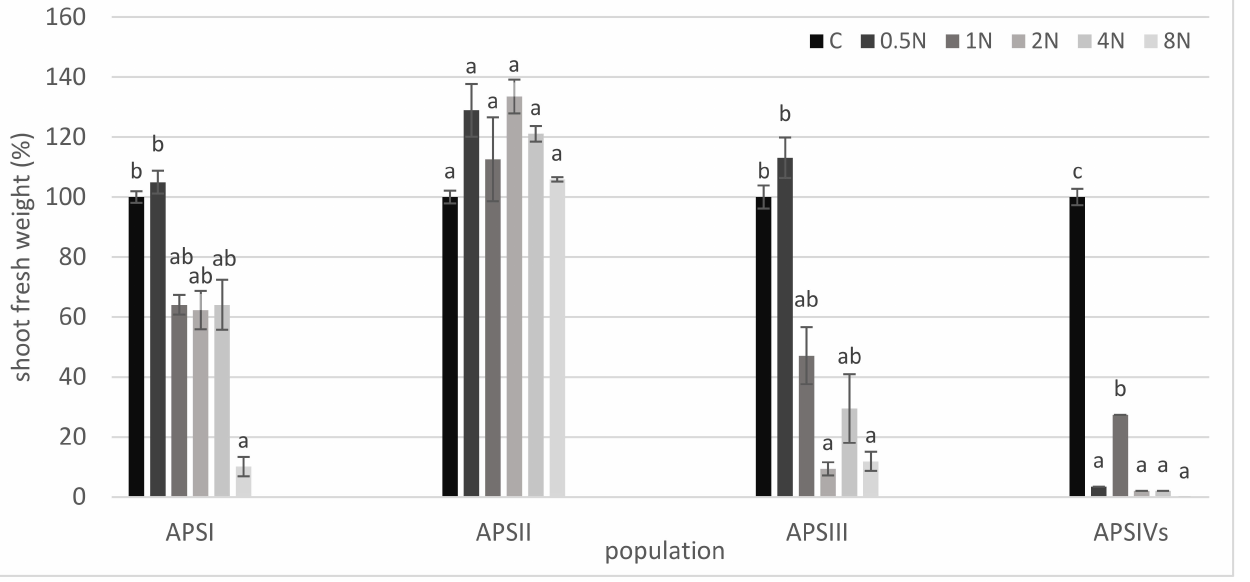
Figure 5. Shoot fresh weight of treated and untreated fenoxaprop-P-ethyl plants of A. spica-venti , expressed as a percentage of the control. The statistical analysis of the significance of differences was performed using the Tukey test for each population separately. Data are means ± SE, n = 3. Means marked by the same letter do not differ significantly. C: untreated